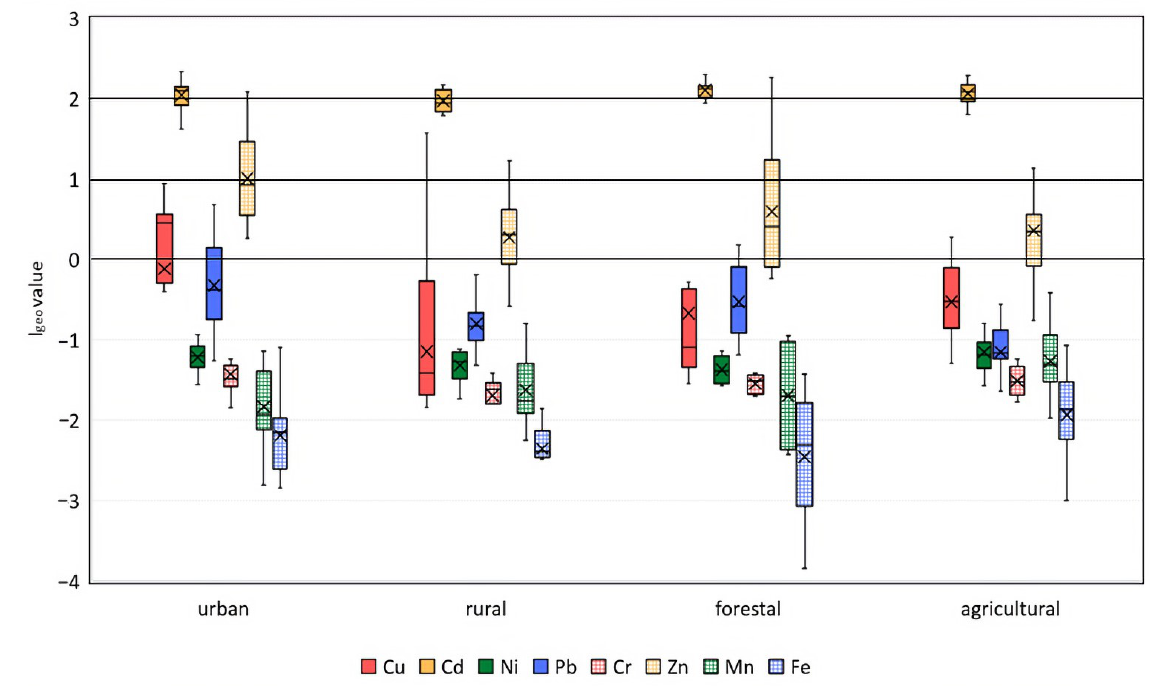
Figure 2. Box plot for I geo of heavy metals in roadside soil.